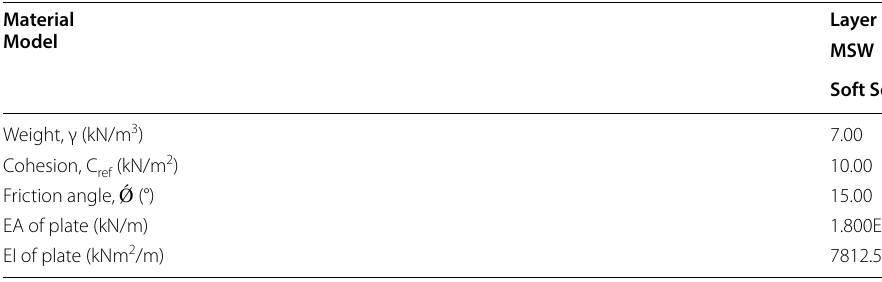
Table 7 Input MSW layer strength